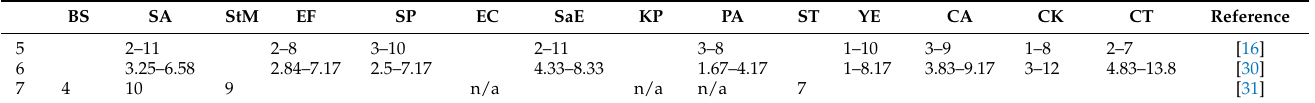
Table 4. Antimicrobial effects of